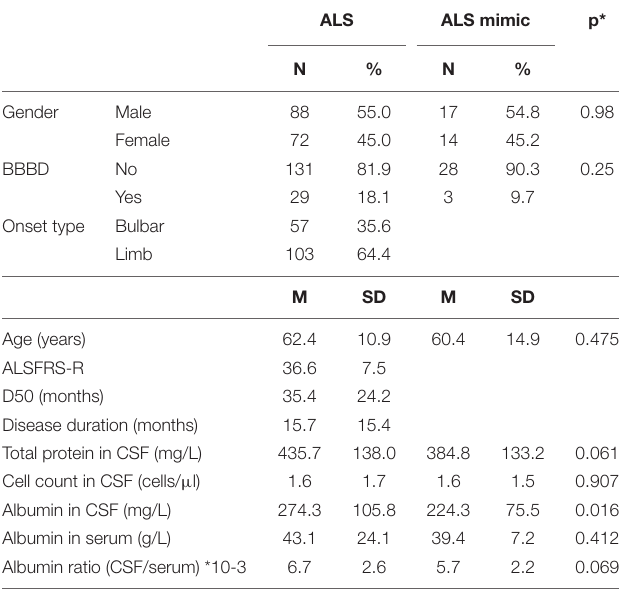
FIGURE 1 | Univariate correlation between disease aggressiveness (D50) and revised ALS-Functional Rating Scale Revised (ALSFRS-R) with the albumin CSF/serum quotient